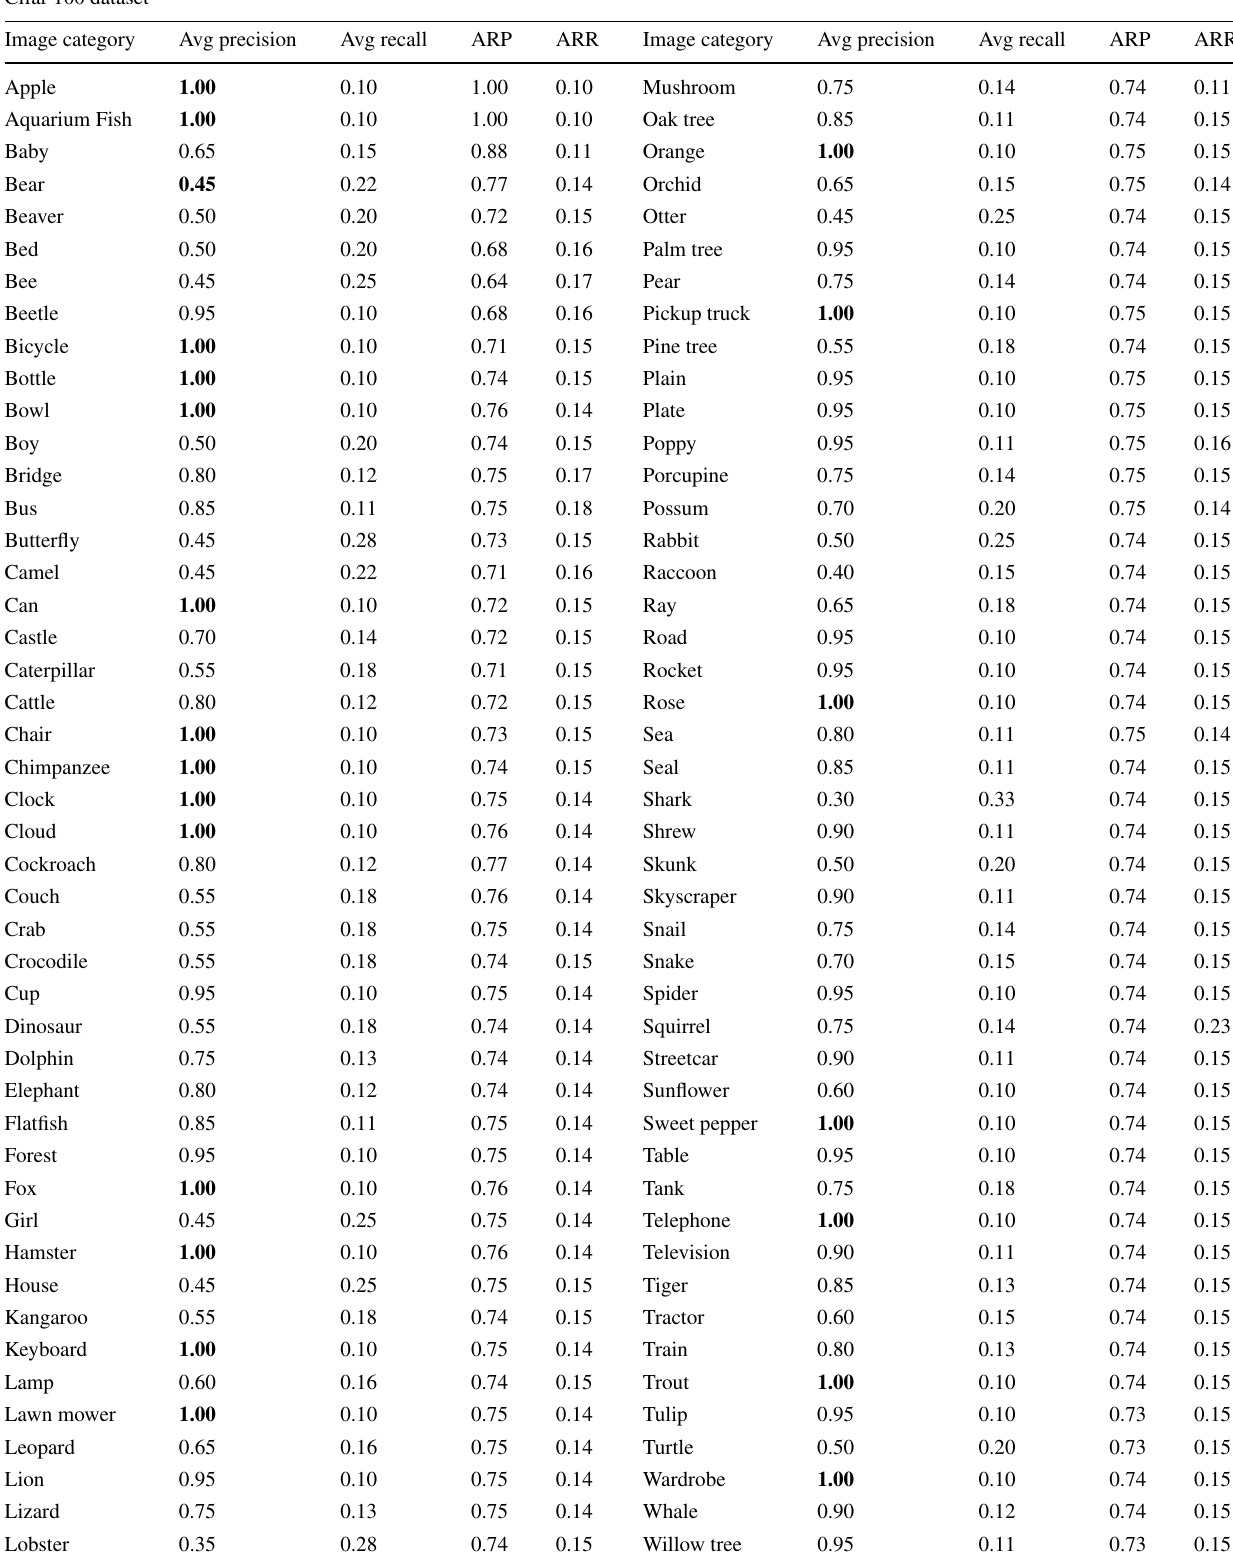
Table 2 Average precision, recall, ARP, and ARR for the cifar 100 dataset Cifar 100